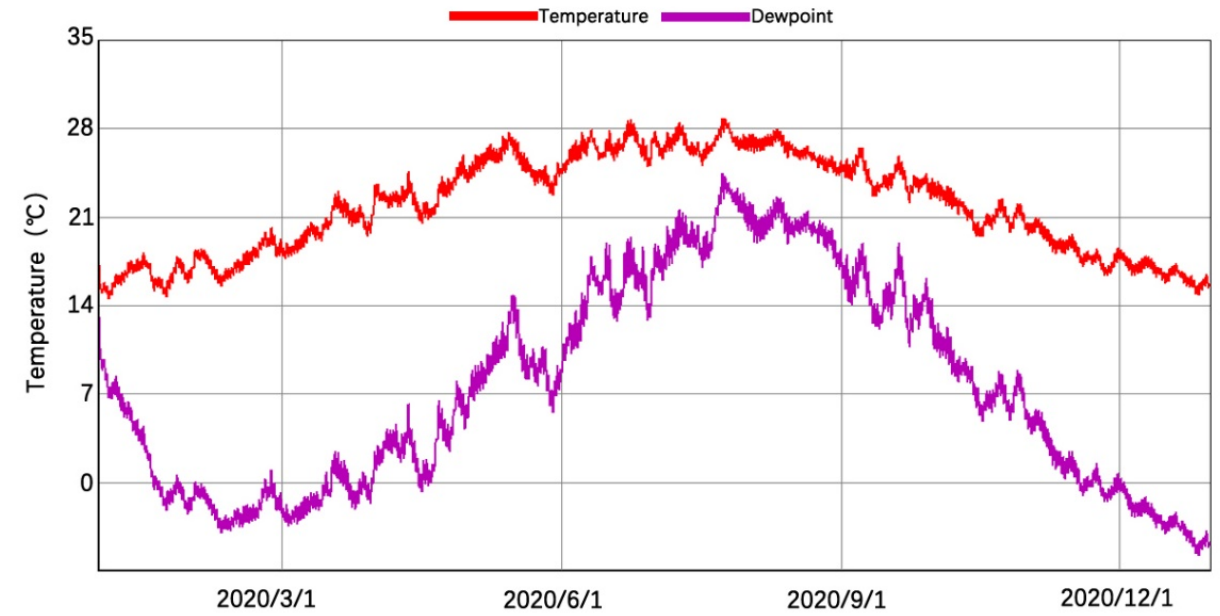
Figure 18. Dewpoint and temperature of monitoring point 3.